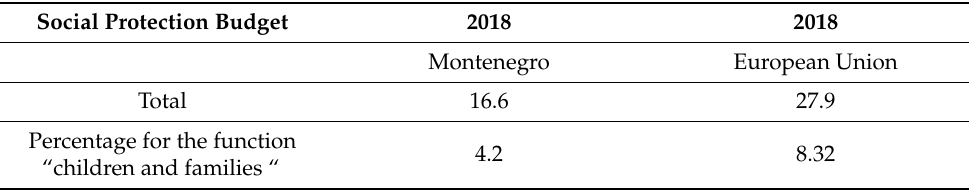
Table 2. Social protection budget in Montenegro and the European Union.